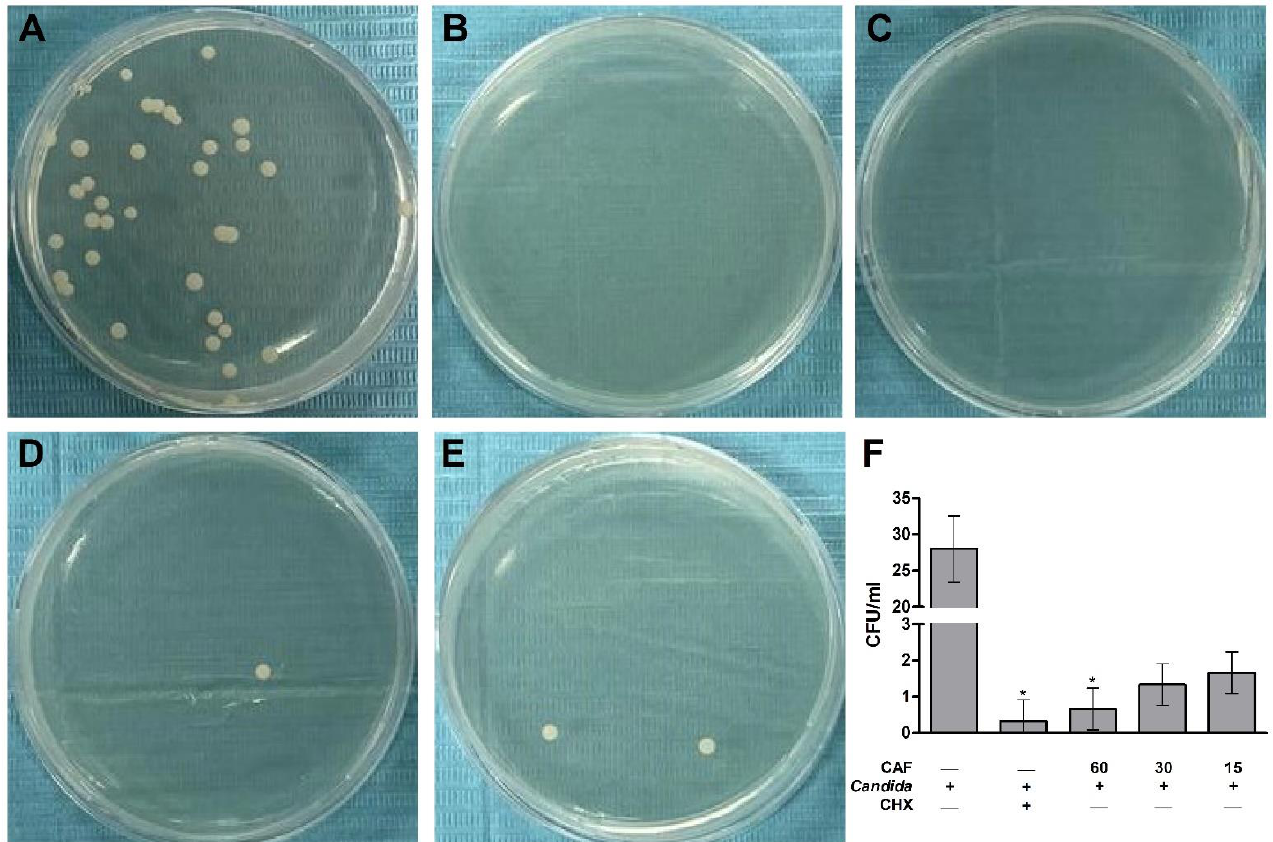
Figure 6. Colony-forming unit (CFU) method for caffeine (CAF) effects against the growth of C. albicans adherent to the PMMA discs. ( A ) Fungal cell growth in control group (PBS) containing no treatments. ( B ) Complete inhibition of the fungal cell growth in chlorhexidine (CHX) group. ( C – E ) Different descending concentrations of CAF including 60, 30, and 15 mg/mL, respectively, showing the dose-dependent effects of CAF and the gradual growth inhibition of fungal cells. ( F ) CFU count of different SDA plates. Data are expressed as mean ± SD ( n = 3) and statistically analyzed using Kruskal – Wallis test and Dunn ’ s post hoc test. The significance was considered when * p ≤ 0 .05 as compared with control.